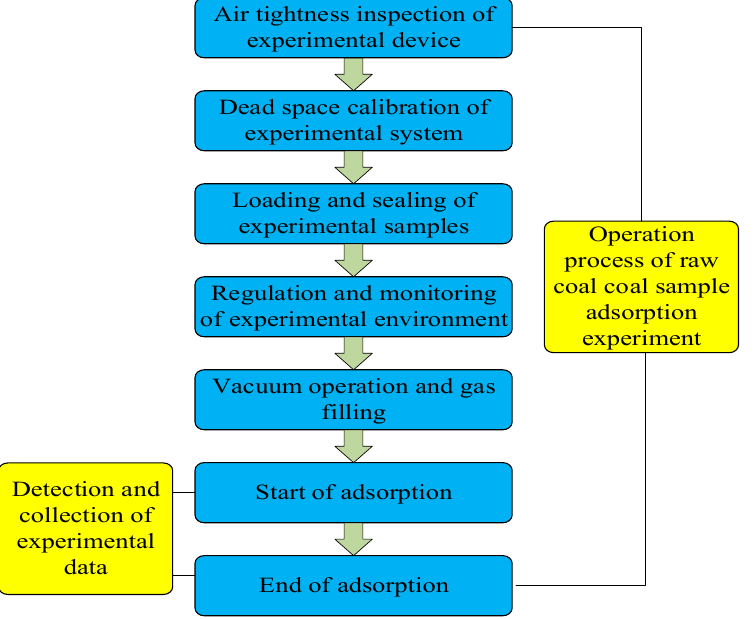
Figure 4. The flowchart of the experimental operation of the CO 2 adsorption process of the loaded coal sample under temperature conditions.